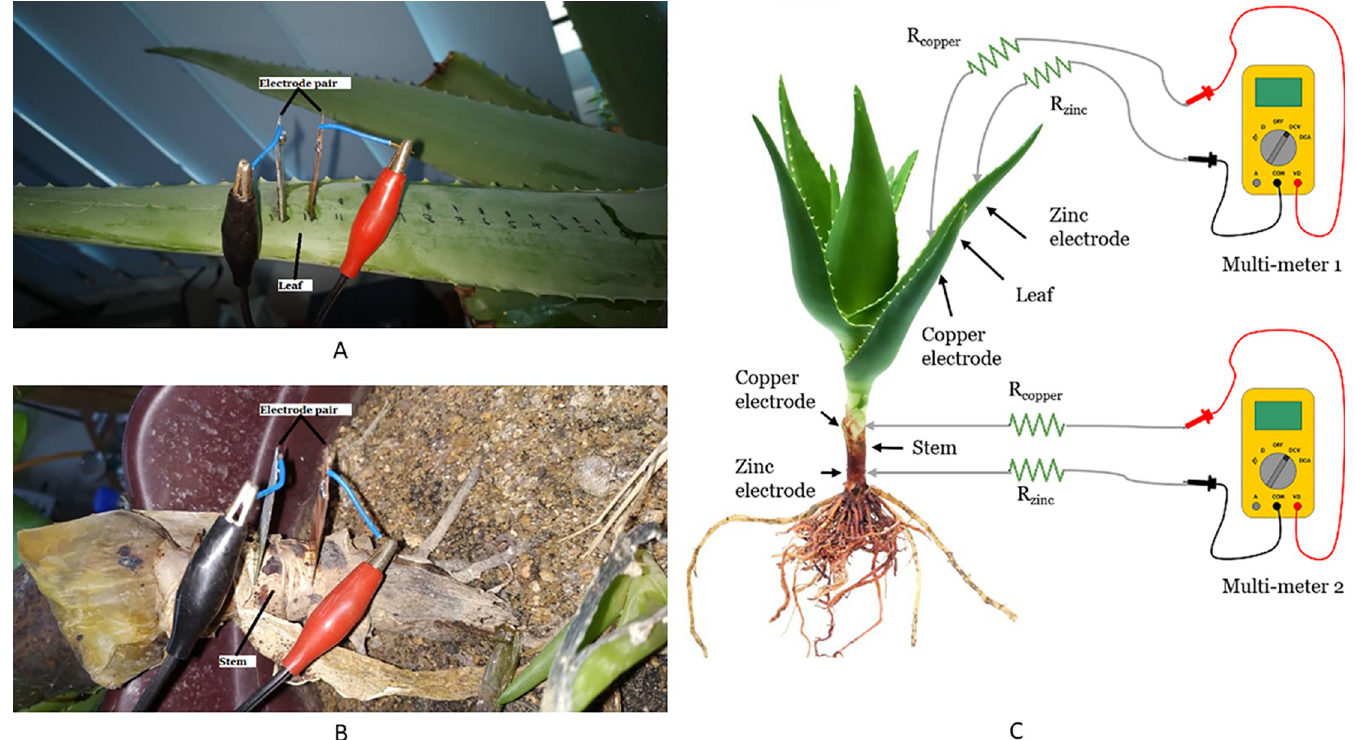
Fig 3. Experiment setup for embedding electrodes in leaf and stem of Aloe Vera. Setup for embedding electrodes in leaf (A), setup for embedding electrodes in stem (B) and simple schematic for both setups (C).